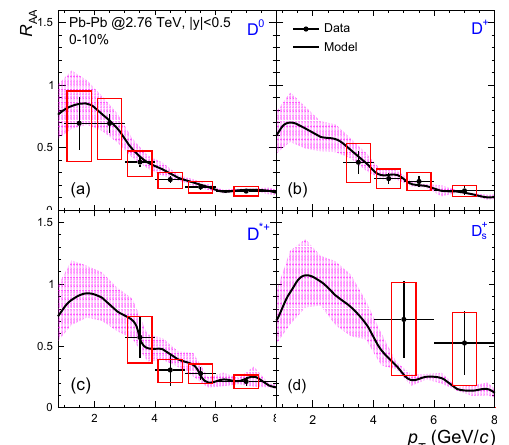
Fig. 7 Comparison between experimental data (red box [54,55]) and soft-hard factorized model calculations (solid black curve with pink uncertainty band) for the nuclear modification factor R AA , of D 0 ( a ), D + ( b ), D ∗+ ( c ) and D + s ( d ) at mid-rapidity ( | y | < 0 . 5) in central √ s NN = 2 . 76 TeV (0–10%) Pb–Pb collisions at